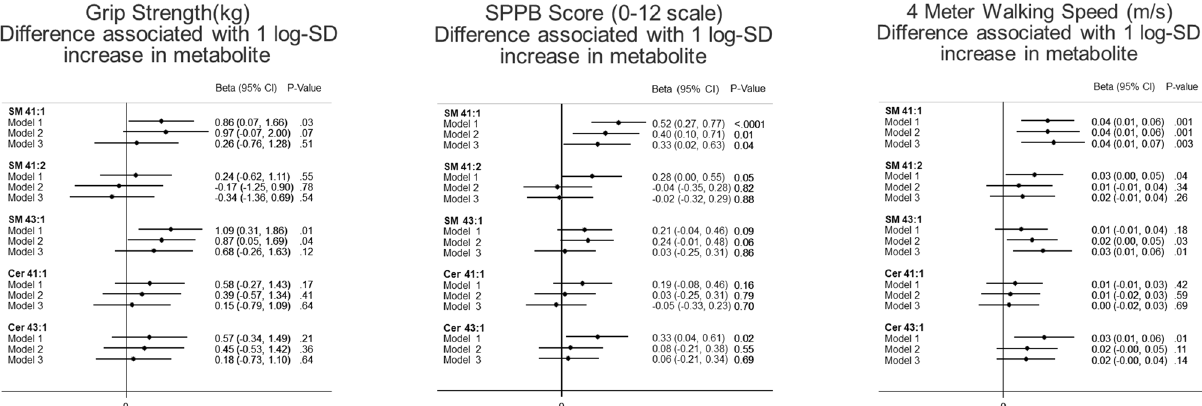
Figure 1. Cross-sectional weighted associations of sphingomyelins and ceramides with physical function in ARIC visit 5. Multiple linear regression model was used to determine β-coefficients [95% confidence internal] between each metabolite (log-transformed concentration modeled in z score) and physical function. Model 1 covariates: age, sex, race-site, and batch effects. Model 2 covariates: model 1, plus body mass index, diabetes status, hypertension status, use of lipid lowering medication, total cholesterol, Digit Symbol Substitution test z-score, and prevalent stroke at the ARIC visit 5. Model 3 covariates: model 2, plus education, presence of an APOE4 allele, Mini-mental state examination (MMSE) score, sports index, previous heart failure, previous coronary heart disease, CES depression score, HDL cholesterol, triglyceride levels, SF bodily pain score, current smoking status, and current drinking